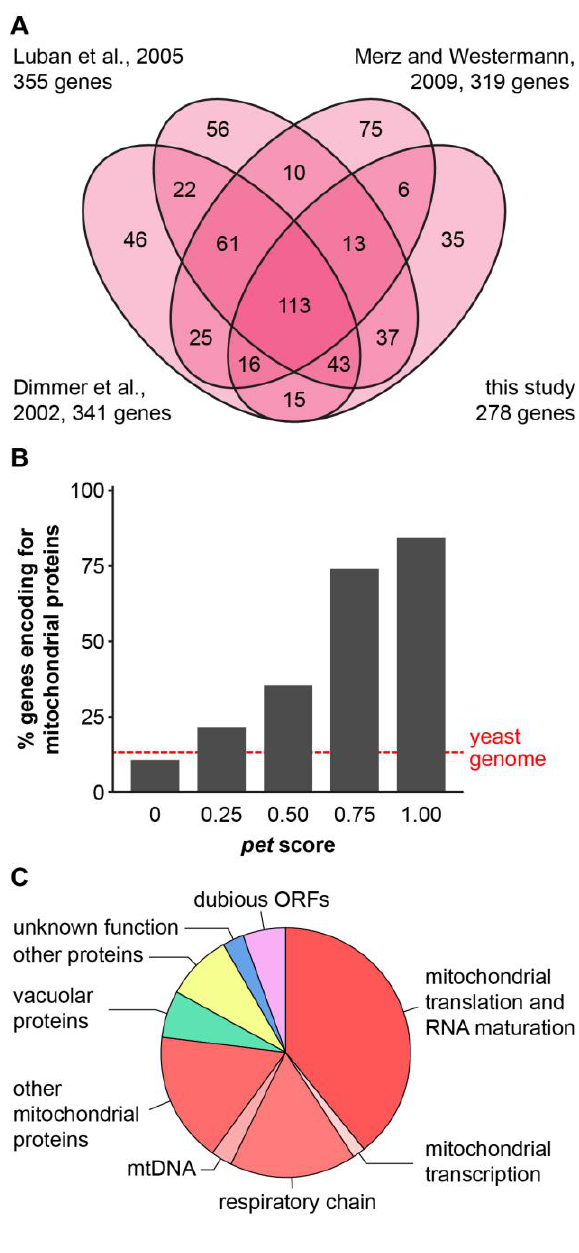
FIGURE 1: Defining a set of high confidence nuclear pet mu- tants. (A) Venn diagram comparing the results of four different screens ([18, 23, 25] and this study) for mutants with a pet phe- notype. In each case, genome-wide collections of viable deletion mutants were analyzed and a pet phenotype was attributed to strains that were unable to grow on rich media containing glyc- erol as nonfermentable carbon source. (B) A pet score was de- rived from the four screens depicted in A by comparing the times a pet phenotype was reported for each gene to the times the deletion mutant was analyzed. See text for details. Viable dele- tion mutants were grouped according to their pet score and analyzed for the percentage of encoded proteins that were found in a high confidence mitochondrial proteome [8]. A de- tailed list containing the results from A and B can be found in Table S1. (C) Mutants with a pet score higher than 0.5, referred to as high confidence pet mutants, were manually grouped into functional categories. Lists of the genes present in each group can be found in Tables 1 and